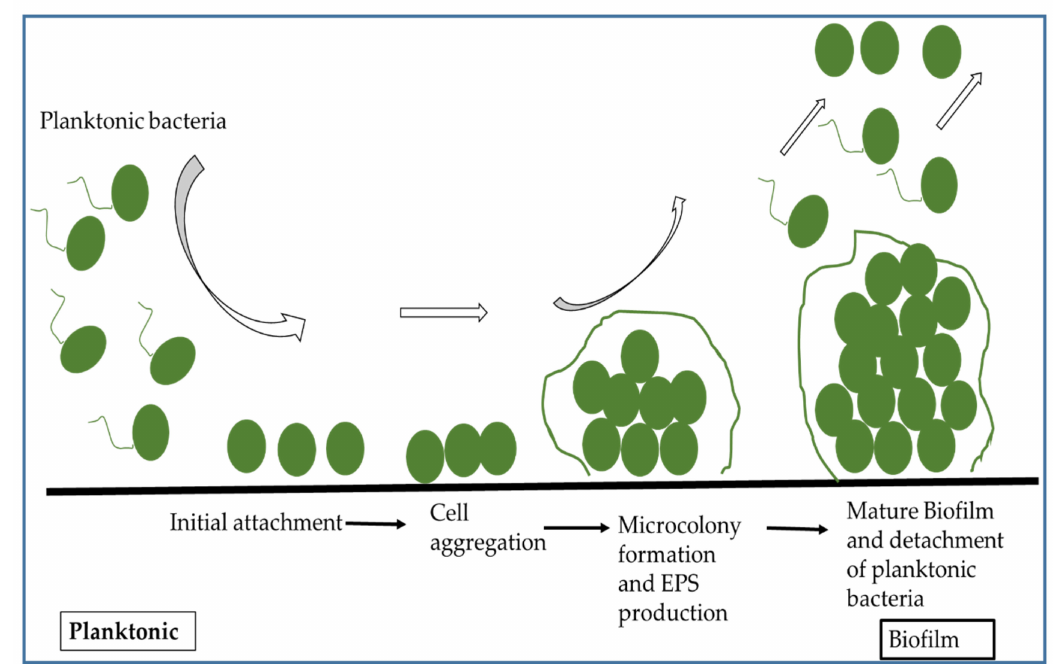
Figure 2. Formation and maturation of a biofilm from the planktonic